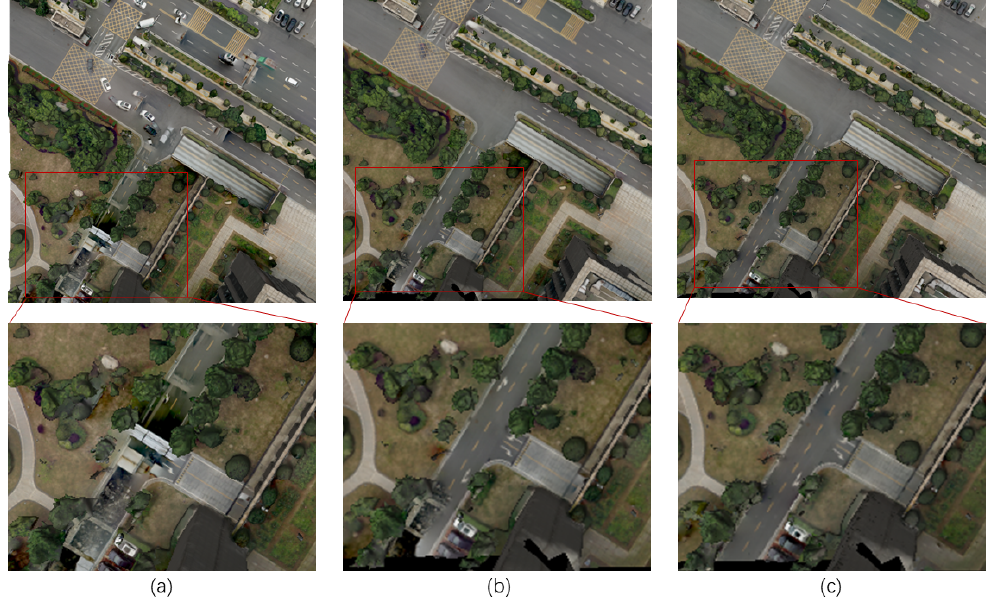
Figure 7. Results comparison without occlusion detection model. ( a ) results of experiments without image consistency detection; ( b ) results of the method of mvs-texturing; and ( c ) results of our